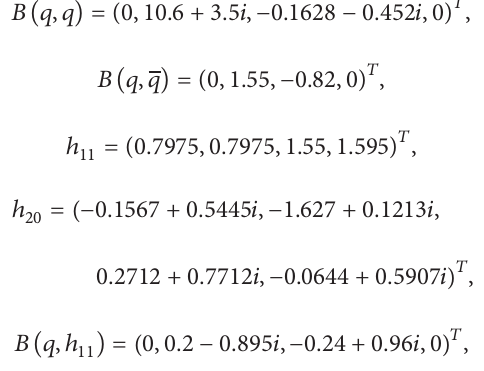
Figure 16: Circuit diagram for realizing the chaotic attractor of system (inside the black-dotted box is the controller).